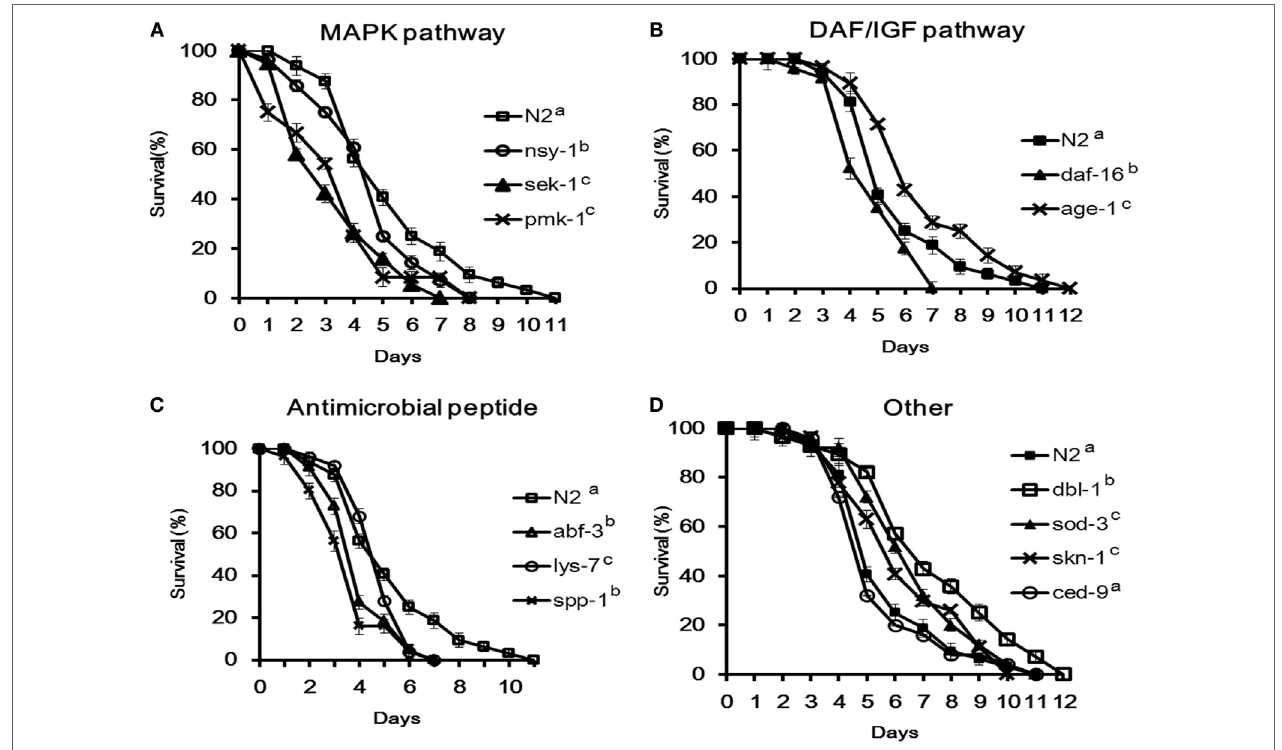
FigUre 3 | Survival of Caenorhabditis elegans mutants infected with Enterotoxigenic Escherichia coli (ETEC) JG280. (a) Survival curves of the mutants defective in the p38-mitogen-activated protein kinase pathway: nsy-1(ag3) , sek-1(ag1) , or pmk-1(km25) ; (B) survival curves of the mutants defective in the DAF/IGF pathway: daf-16(mu86) or age-1(hx546) ; (c) survival curves of the mutants defective in antimicrobial peptide genes: lys-7(ok1384) , abf-3(ok3366) , or spp-1(ok2703) ; (D) survival curves of the mutants defective in genes with other functions: dbl-1(nk3) , sod-3(gk235) , skn-1(zu67), or ced-9(n1950). All the groups were infected with ETEC JG280 after 18 h incubation with E. coli OP50 in the life-span assay. The wild-type (N2) served as a reference. All the groups showing different letters were significantly different ( P ≤ 0.01) in their survival